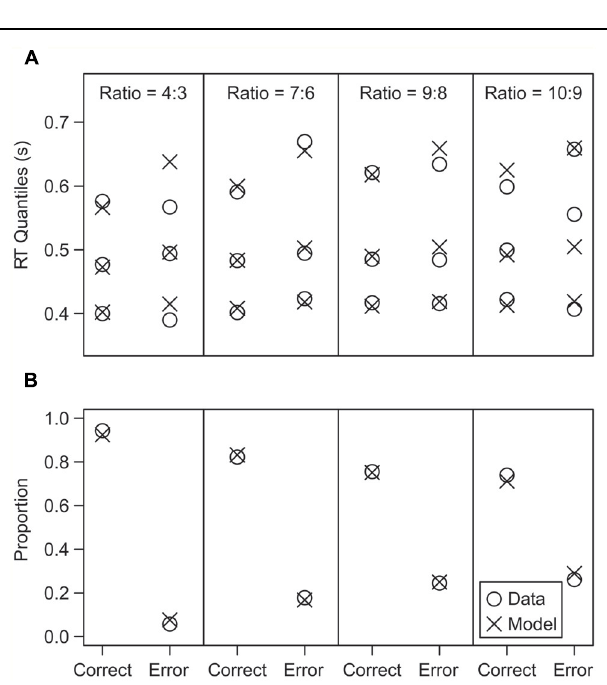
of items on each side remained the same but the total number of items increased substantially: 12:9 dots vs. 21:18 dots and 14:12 dots vs. 20:18 dots. For both pairs, accuracy was